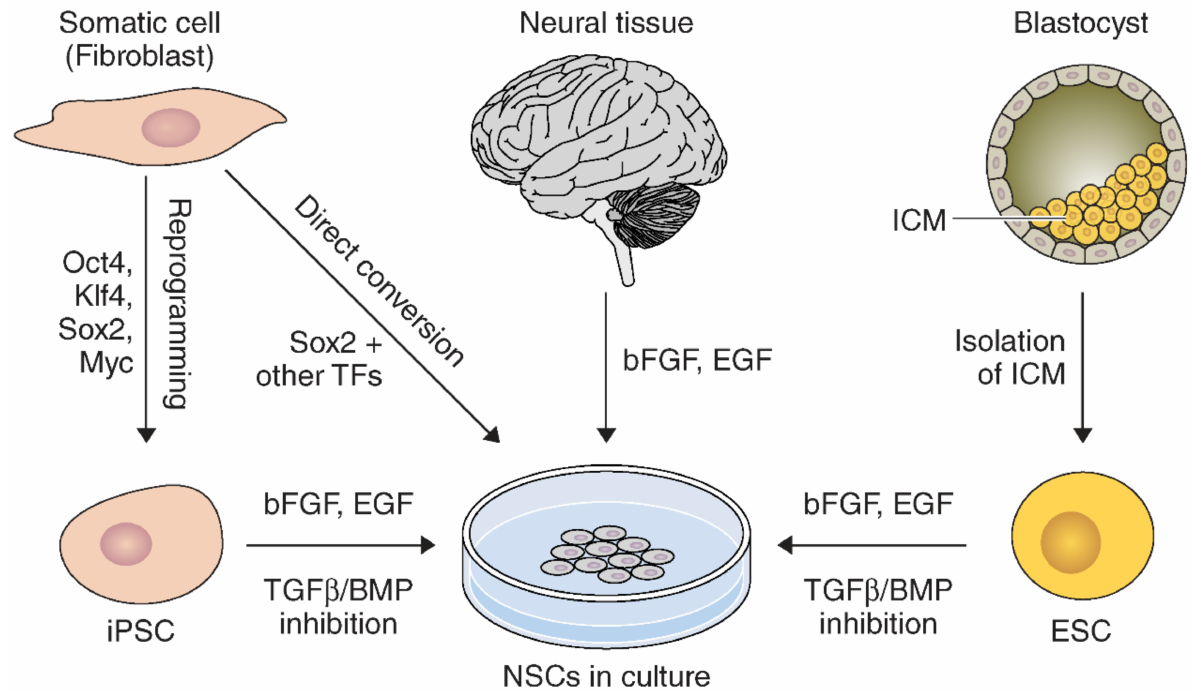
Figure 1. Schematic diagram of NSC derivation through diverse methods and sources. NSCs can be directly extracted from neural tissue and expanded in vitro. Also, NSCs can be reprogrammed from iPSCs or ESCs by specific combinations of differentiation factors. Further, NSCs can be generated by direct conversion of somatic cells omitting the iPSC derivation step. ICM, inner cell